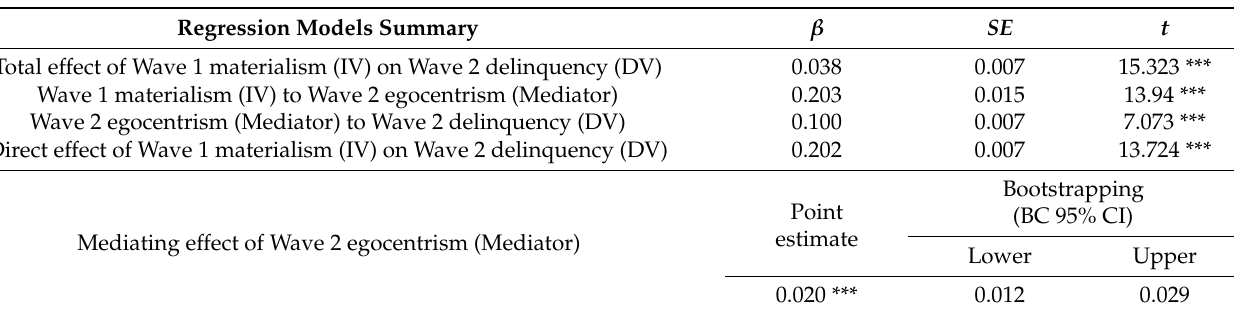
Table 6. Mediating effect of Wave 2 egocentrism (the mediator) for the effect of Wave 1 materialism on Wave 2